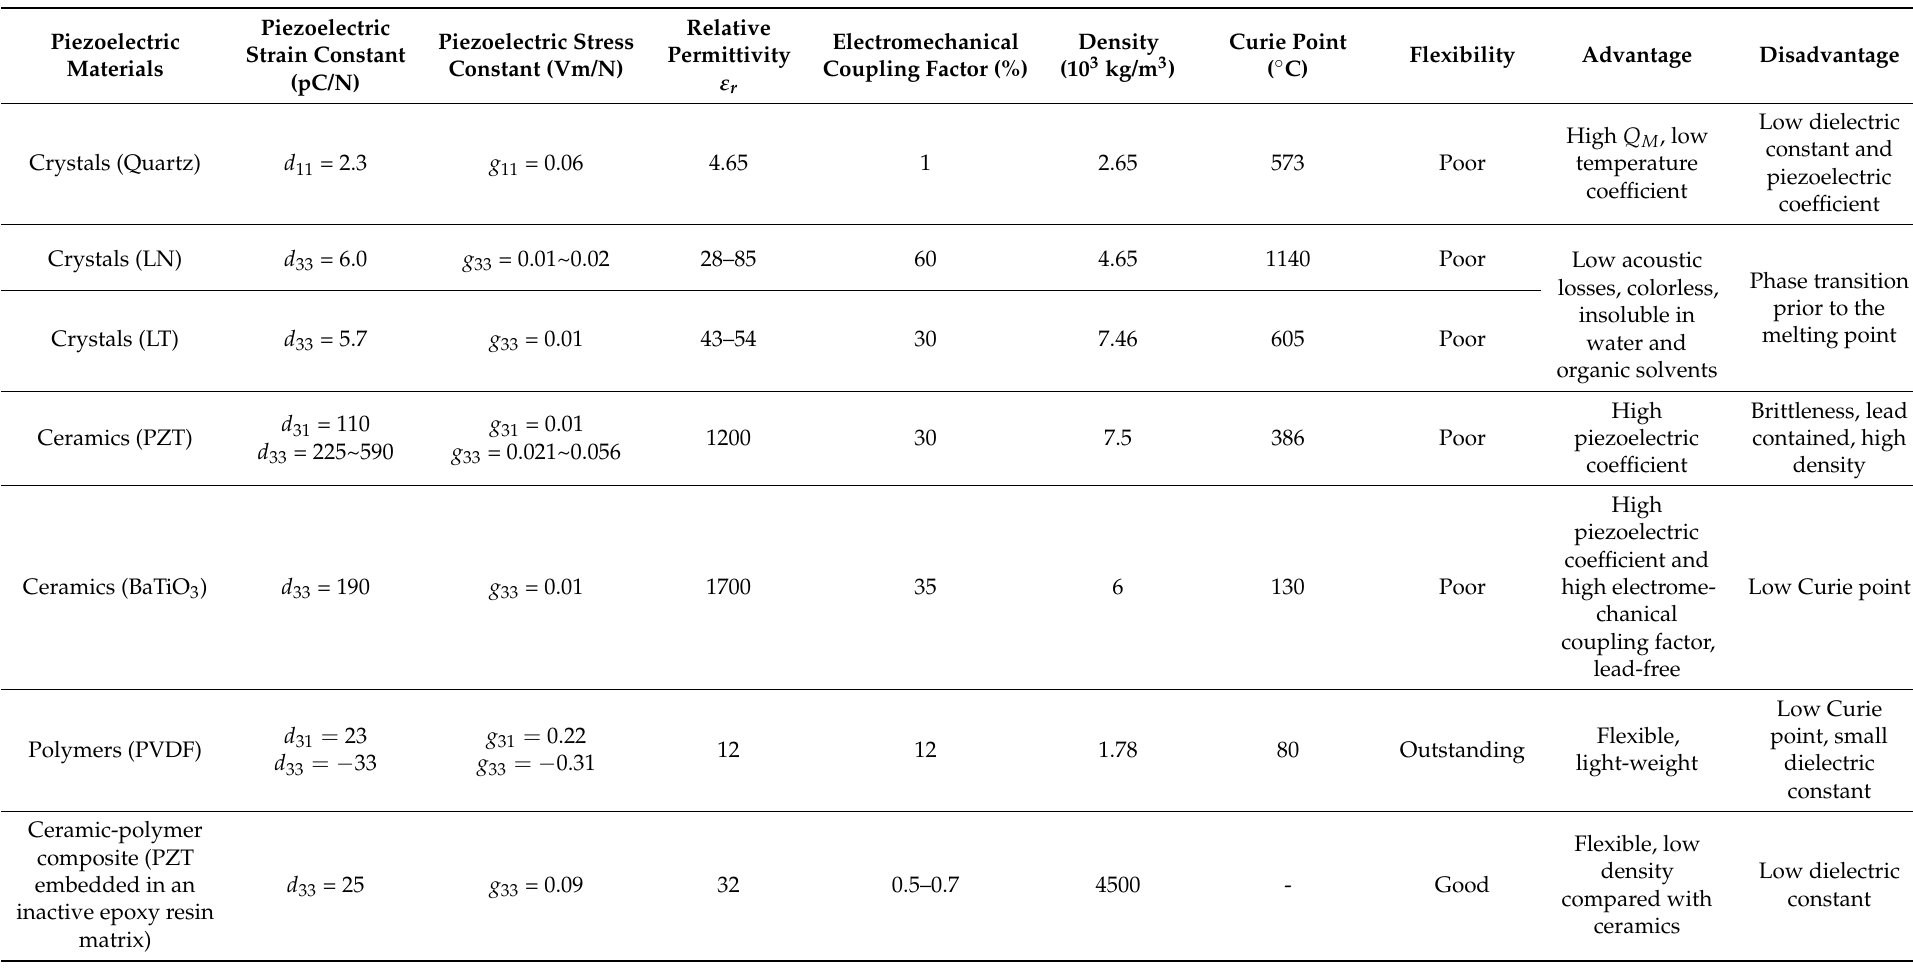
Table 1. Comparison of the commonly used piezoelectric materials